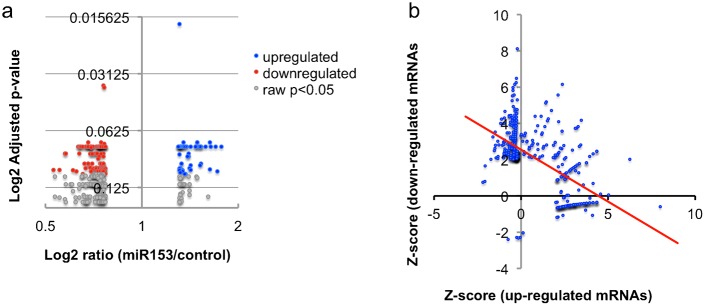
Microarray analysis of gene expression following miR-153 over-expression.(a) Volcano-plot illustrates relationship between log2(mRNA expression ratio) and log2(FDR-corrected p-value) in miR-153 over-expressing cultures compared to controls. Filled red and blue circles indicate mRNA transcripts that are suppressed or induced, respectively, by more than 1.3-fold following miR-153 over-expression, at an FDR (Benjamini and Hochberg)-adjusted p<0.1. Gray circles indicate genes that reached statistical significance at a raw p<0.05. Data summarized from 6 independent replicate experiments. (b) The plot shows the correlation of gene ontology analysis of mRNA transcripts that were suppressed and induced following miR-153 over-expression. The x-axis depicts the z-score of ontology analysis of mRNAs induced by miR-153. The y-axis indicates the z-score of ontology analysis of mRNAs suppressed by miR-153. The red line is the regression line that indicates a negative linear relationship between ontology classes of miR-153 suppressed and induced mRNA transcripts.